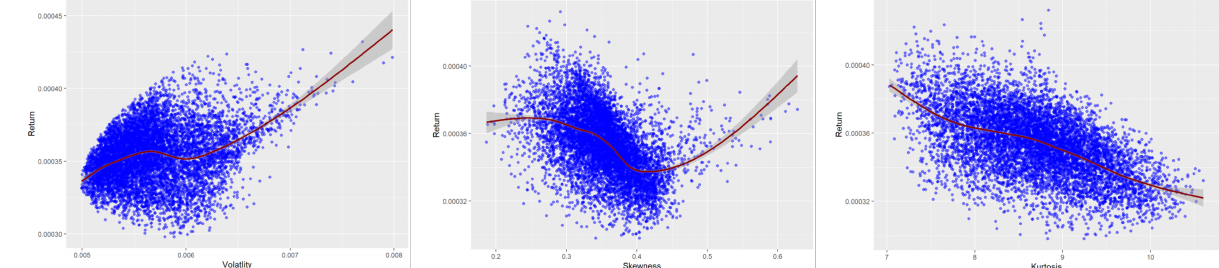
Figure 4. Scatterplot demonstrating the relationship between portfolio return, skewness, and kurtosis of Stocks.